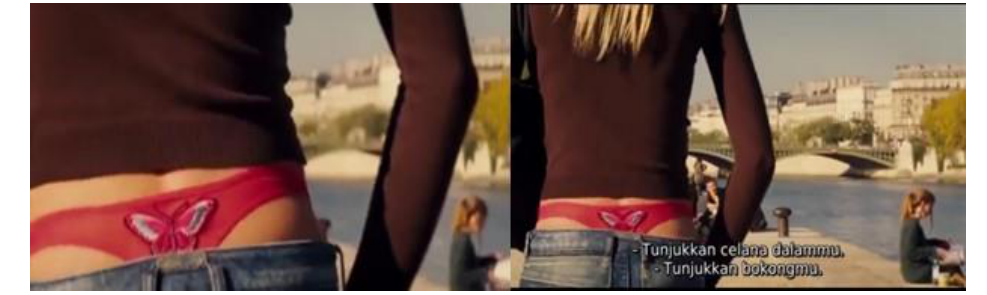
Figure 1 La gaze masculine dans le film (minutes 00: